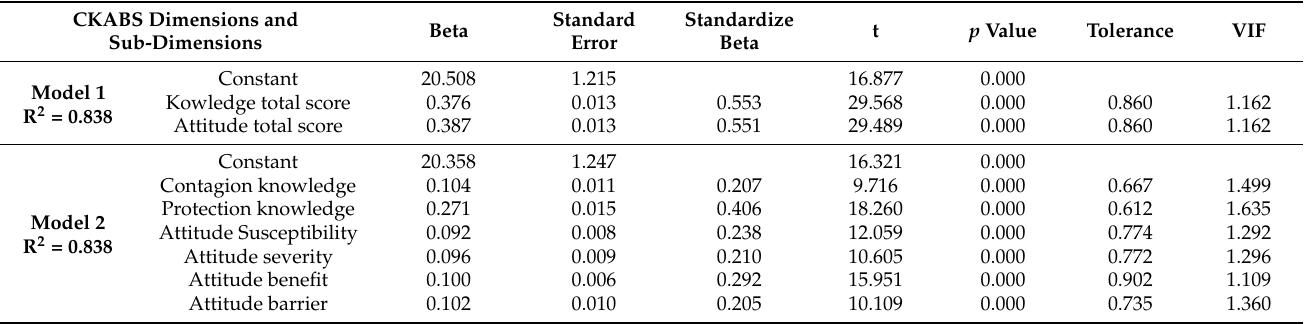
Table 6. The Relationship Between Behavior Total Score and Knowledge and Attitude, Linear Regression Analysis